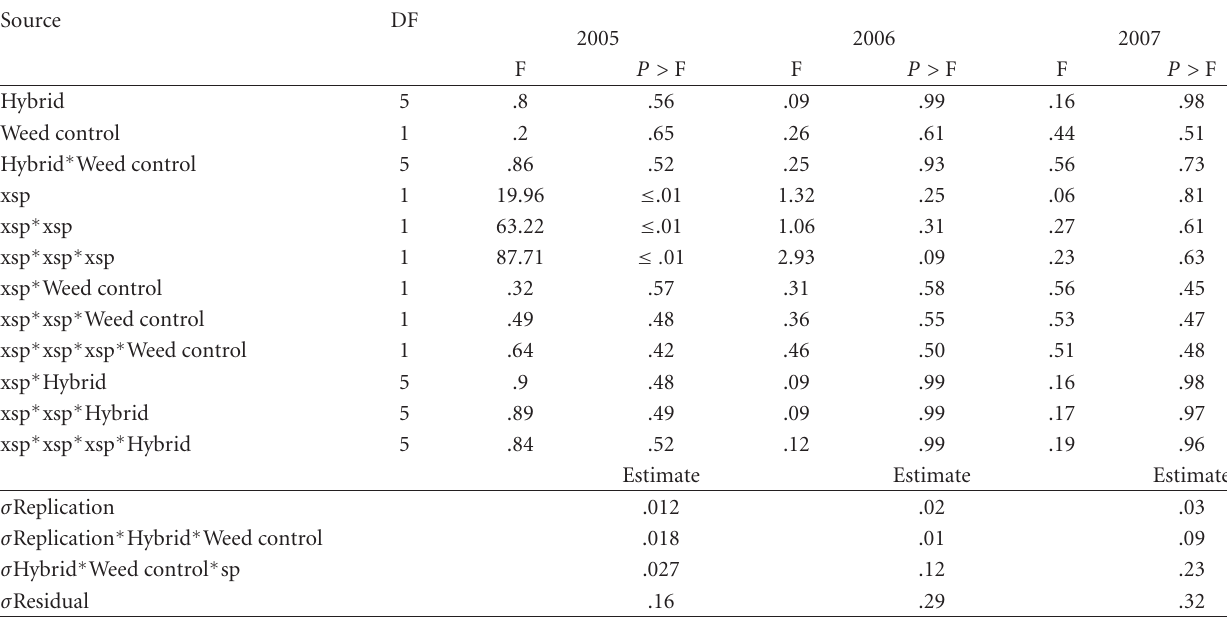
Table 3: Type III Test of Fixed E ff ects of Two Methods of Weed Control on LAI of Herbicide Resistant Corn Hybrids Grown at Stoneville, MS for Three Years.